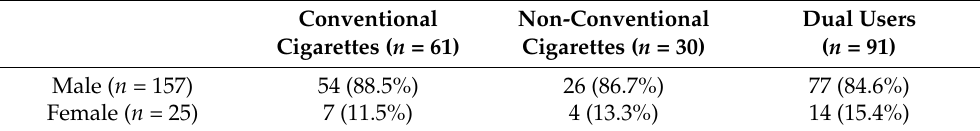
Table 3. Smoking device use by gender of participants ( n =